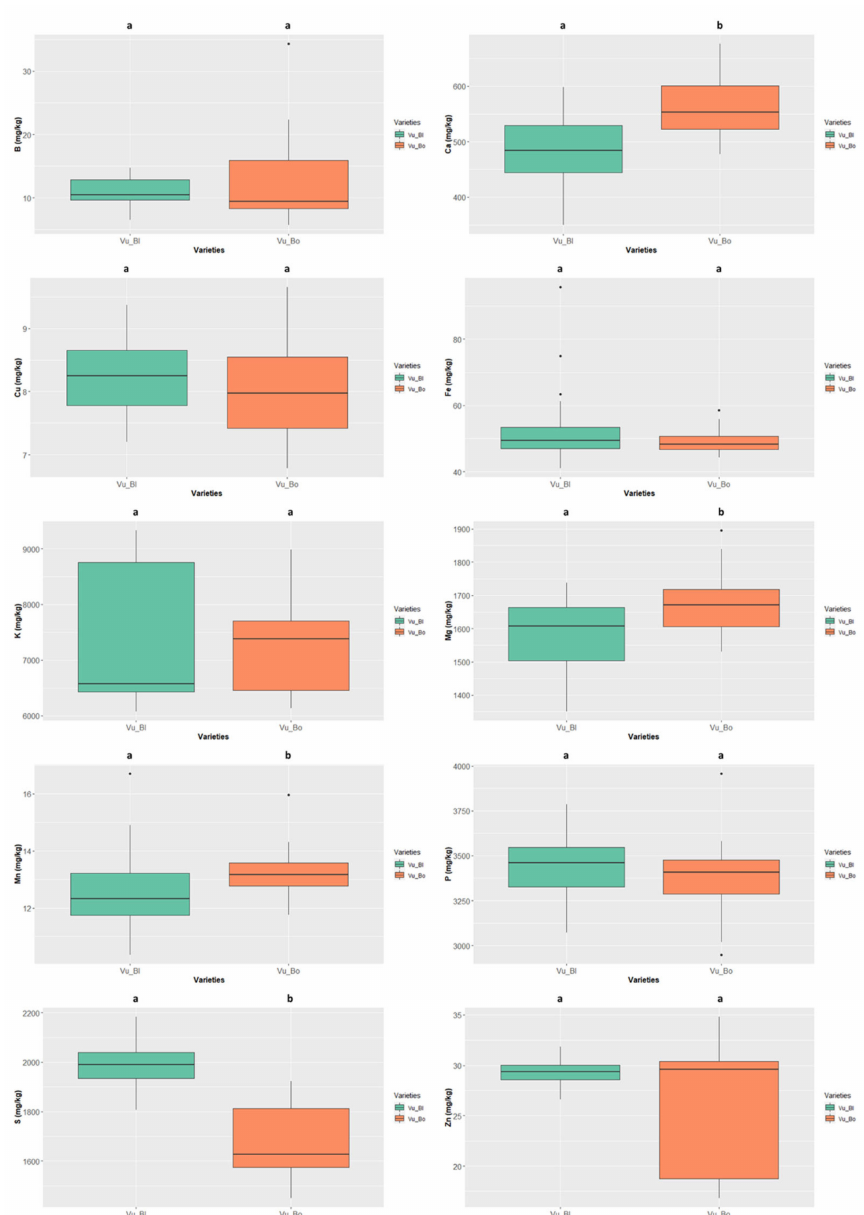
Figure 10. Variation of the content of the 10 minerals quantified in the different colour types of Vigna unguiculata . The box represents the 25th, 50th (median), and 75th percentiles, while the whiskers represent the 10th and 90th percentiles with minimum and maximum observations. The dots represent the outliers. Different lower-case letters indicate significance differences ( p < 0.05) between